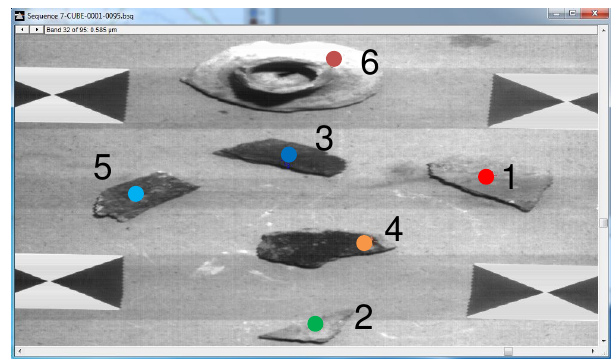
Figure 7. The hyperspectral scene of fragments. All samples were selected for the hyperspectral plot and numbered.